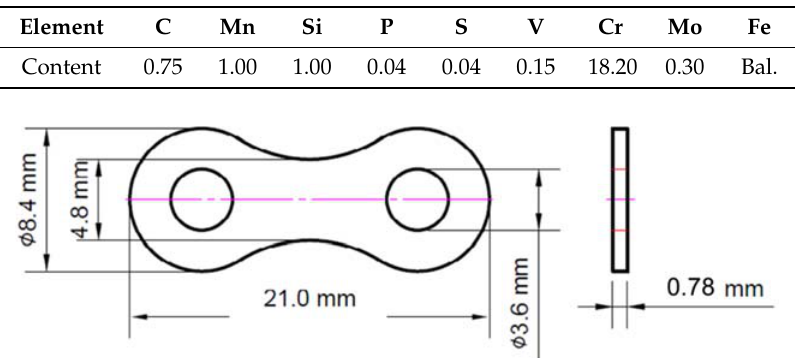
Figure 1. Configuration of a double-loop thin plate specimen.